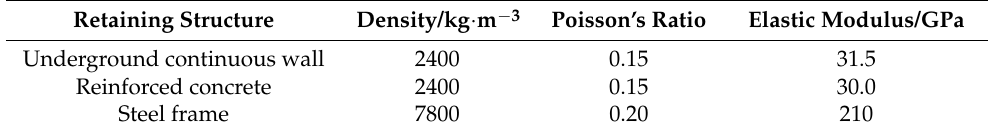
Table 2. The mechanical parameters of the retaining structure of the excavation.